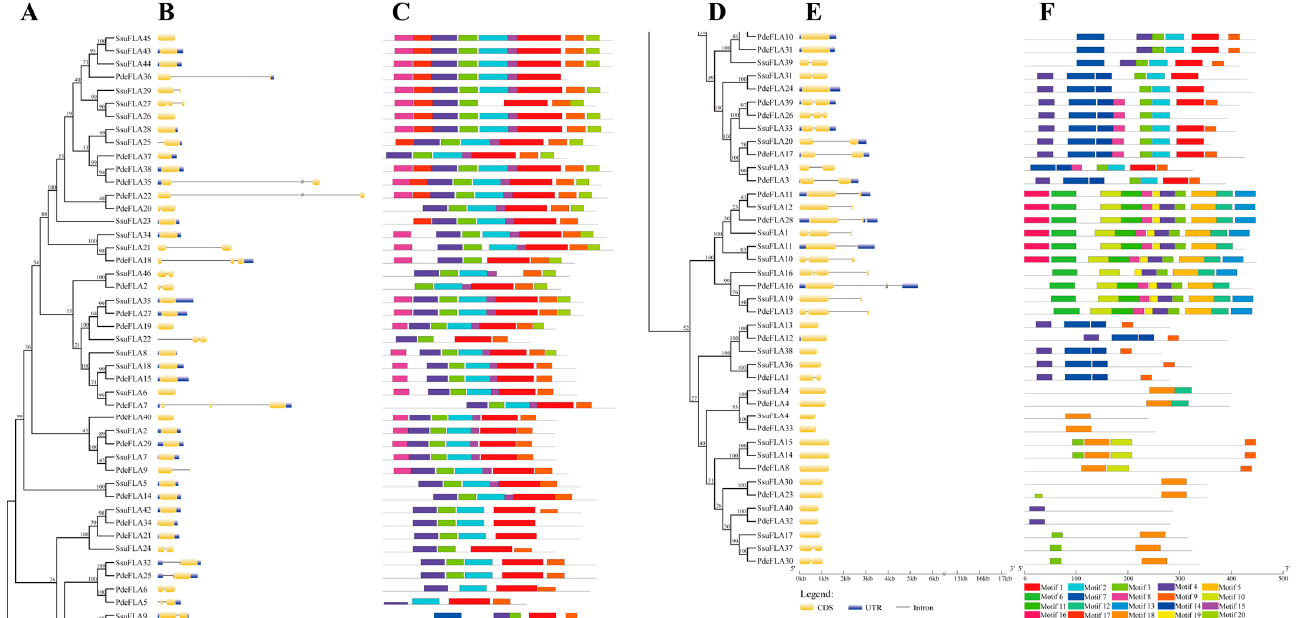
Figure 3. Phylogenetic relationships, gene structures, and motif compositions of FLA genes in P. deltoides and S. suchowensis . ( A ) Phylogenetics of FLA genes. ( B ) Genetic structure of exons and introns in each FLA gene. The yellow boxes represent exons and the single black lines represent introns. ( C ) The conserved motifs contained in each FLA protein. ( D ) Continuation of ( A ). ( E ) Continuation of ( B ). ( F ) Continuation of ( C ). Each motif is indicated using colored boxes and single black lines indicate non-conserved sequences. The bottom scale allows estimation of the size of each motif.